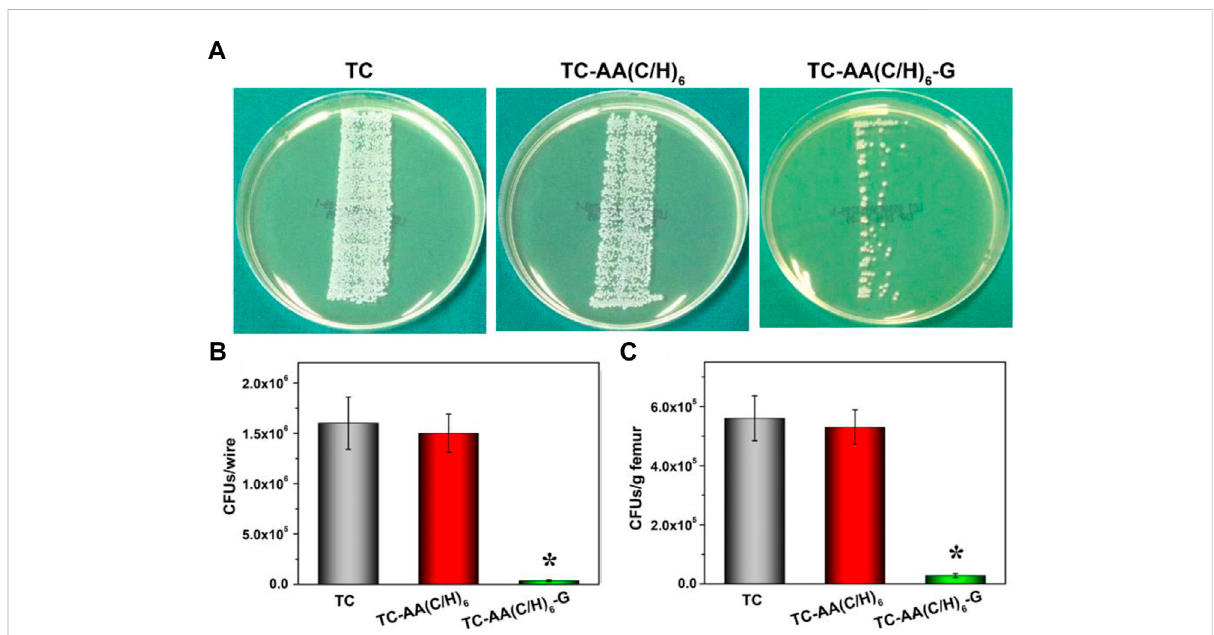
FIGURE 8 Quanti fi cation ofbacteriaobtained from explanted implants and bonetissueon dayof sacri fi ce. (A) Growth ofbacterialcolonies ofimplantson TSA; (B) The number of CFU per implant; (C) Amount of CFU per gram of bone. * p < 0.05 compared with TC-AA(C/H) 6 -G and other two groups.